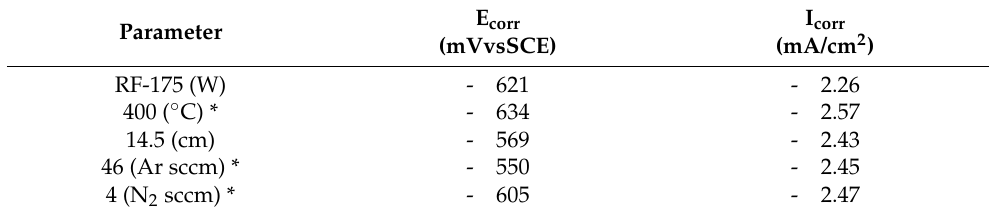
Figure 4. Cyclic potentiodynamic curves of coated and uncoated AISI 1060 samples in 3.5 wt% NaCl solution at room conditions varying the following sputtering parameters: ( a ) RF-power, ( b ) temperature on substrate, ( c ) target – substrate distance, ( d ) argon flow mass, and ( e ) nitrogen flow mass. Table 3. Fitting results of potentiodynamic polarization curves with the best behavior immersed in 3.5% NaCl solution.